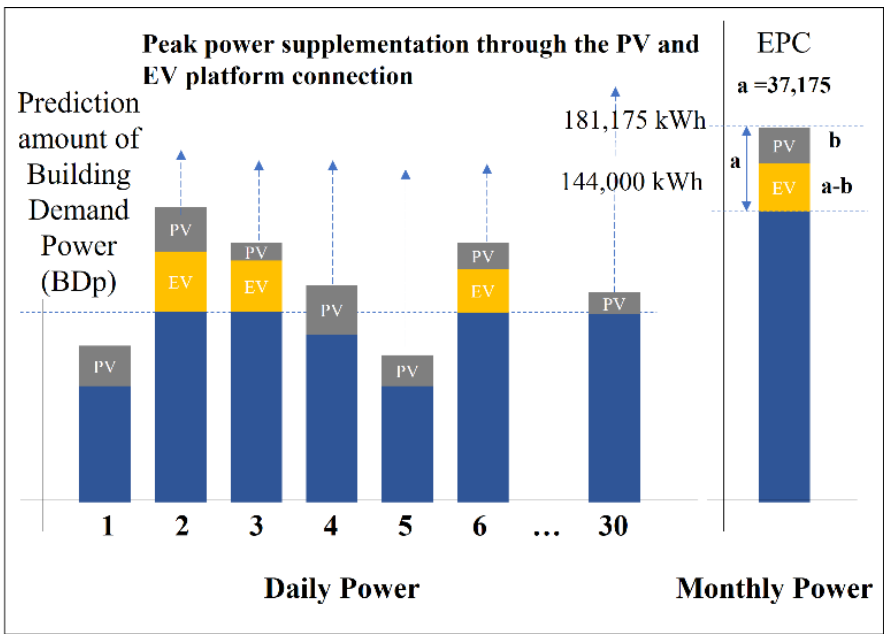
Figure 17. Peak power supplementation through the PV and EV.